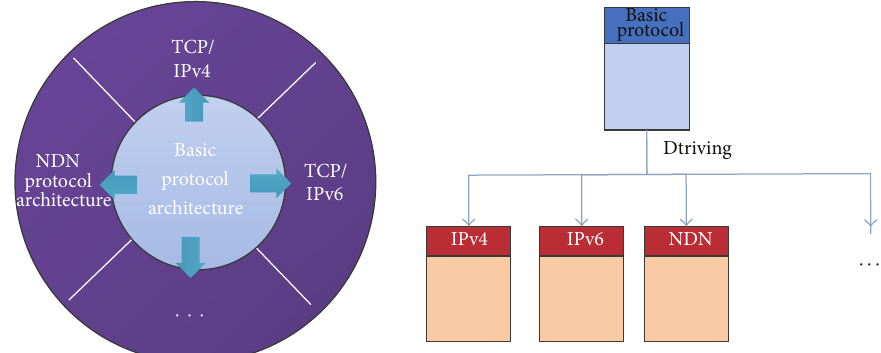
Figure 4: The basic protocol architecture and the polymorphic protocol architecture.